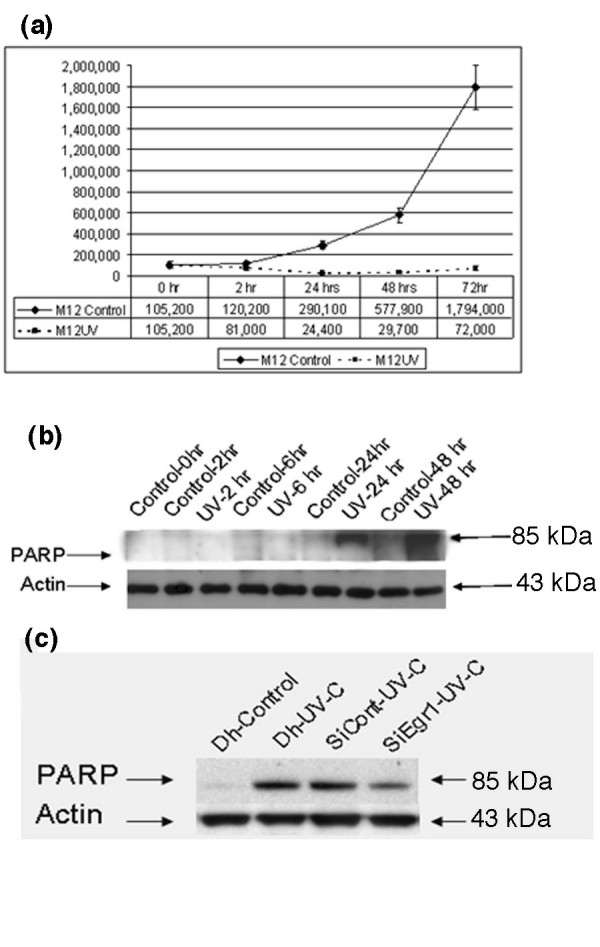
Role of Egr1 in apoptosis. (a) Growth curve of M12 cells over a period of 72 h, with or without UV-C irradiation. The experiments were performed in triplicates and the error bars represent the data from the triplicate experiments (b) Western blot analysis of M12 cells treated with UV-C, and collected at varying time points after UV irradiation. Anti-PARP (to demonstrate apoptosis) was used to identify PARP cleavage product (this antibody only detects the cleaved product and not the native protein). (c) M12 cells were treated with SiGenome control and SiEgr1 and followed by UV-C stimulation. Cells were collected after 24 h of UV treatment, and western blot analysis, using anti-PARP, showed that Egr1 is involved in apoptosis of M12 cells.